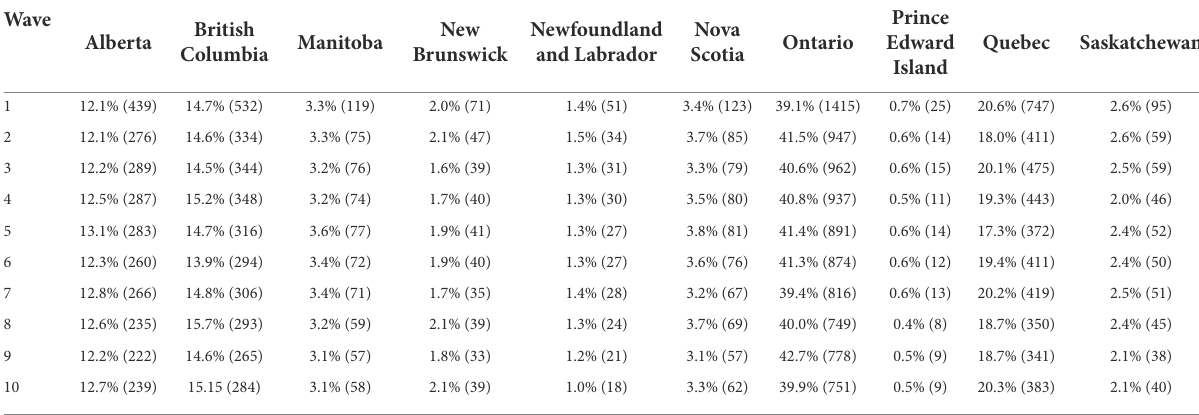
TABLE 2 Distribution of participants according to province of residence.